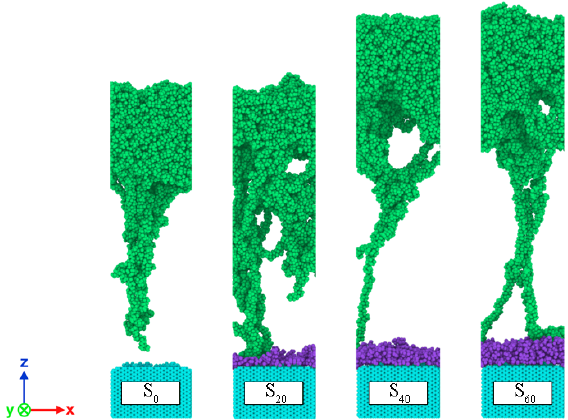
Figure 14. Morphology of tensile failure of the S i interface system at 100 ps.